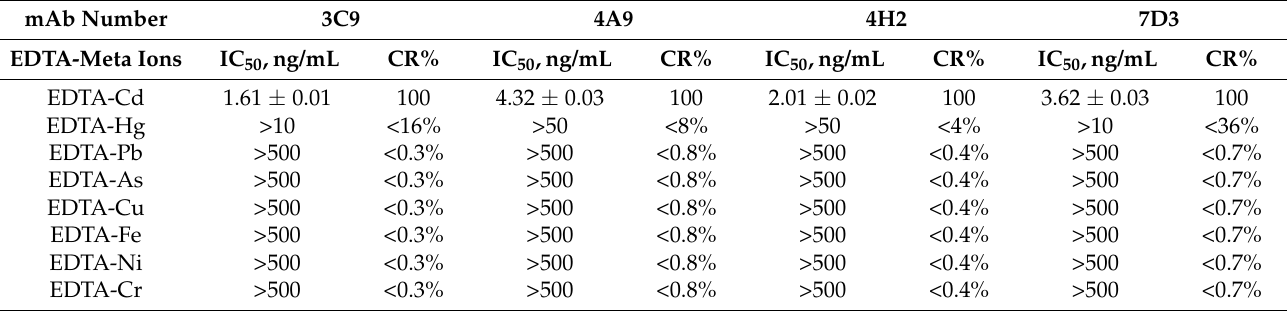
Figure 6. Standard curves of different mAbs for Cd 2+ detection by ic-ELISA. ( A ) 3C9; ( B ) 4A9; ( C ) 4H2; ( D ) 7D3. Table 2. Cross-reaction rate of four mAbs for EDTA-metal ions.